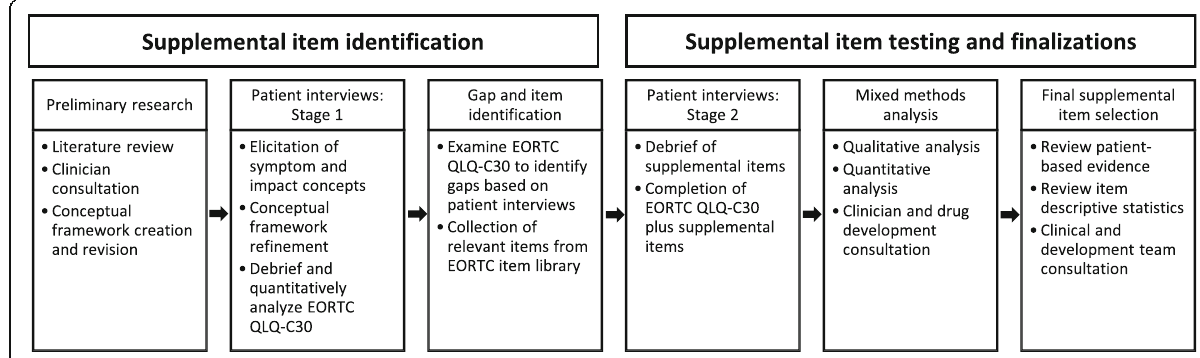
Fig. 1 Mixed methods study